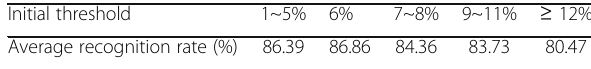
Table 11 Average recognition rate of different initial thresholds on CASIA Initial threshold 1%, 3%